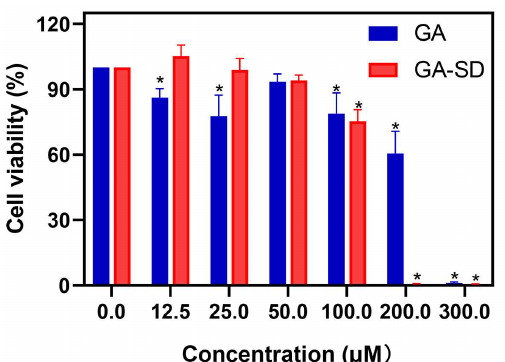
are the means ± SD ( n = 4). 0 µM represents the control group. * p < 0.05 vs. Control. the means ± SD ( n = 4). 0 µ M represents the control group. * p < 0.05 vs. LPS stimulation of the mouse peritoneal mononuclear macrophage cell Line 264.7